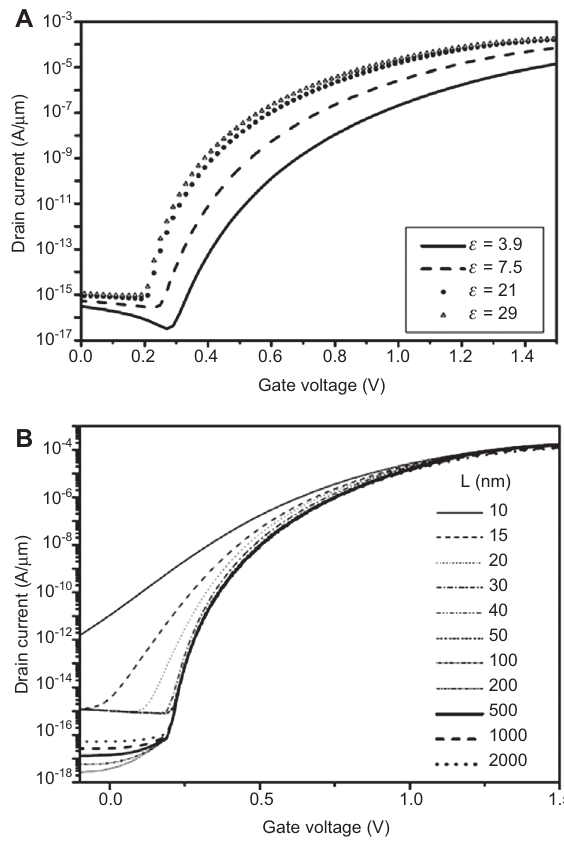
Figure 12 (A) Comparison of transfer characteristics of TFETs with different gate dielectrics by simulation. Four different gate oxides with the same physical thickness of 3 nm are used in the simulation. By using high- κ gate dielectric, both the drive current and SS of TFETs are improved due to better gate coupling. (B) Comparison of the transfer characteristics of TFETs with different channel lengths. The ON-state current of TFET does not obviously change with reduced channel length; however, OFF-state leakage current increases by several orders of magnitude with scaling of channel length. OFF-state current increases sharply with channel length < 50 nm. Reprinted from Ref. [16], with permission, from